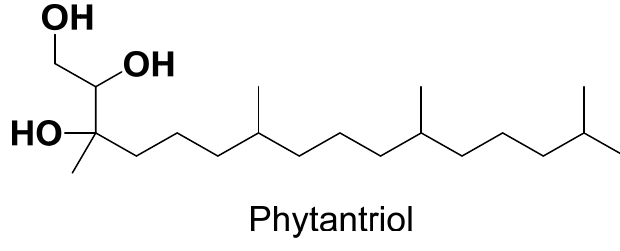
Figure 3. Structure of phytantriol.